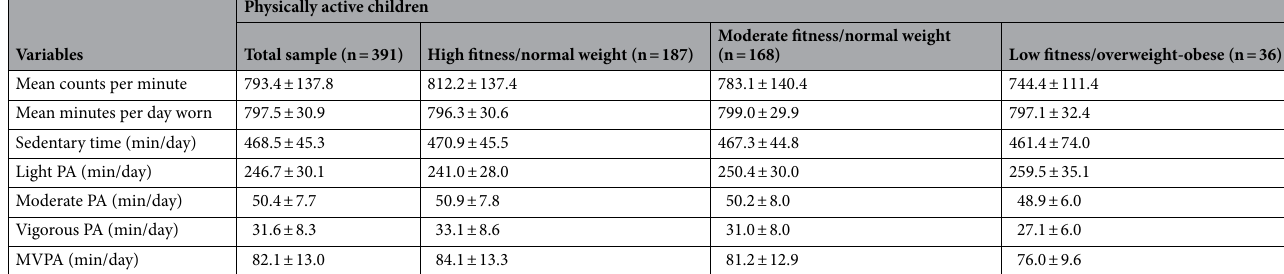
Table 2. Physical Activity and Sedentary Behaviour Profile for the whole sample and according to based- group trajectory. Data are presented as mean ± SD for continuous variables. PA physical activity, MVPA moderate-to-vigorous physical